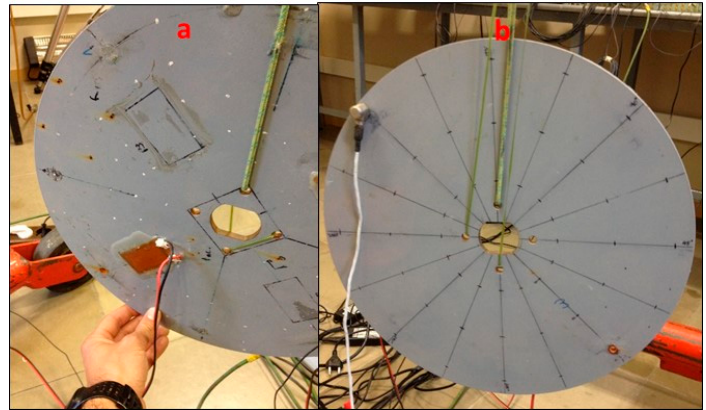
Figure 1. ( a ) Tested structure with installed PZT; and ( b ) installed Accelerometer (back side of the